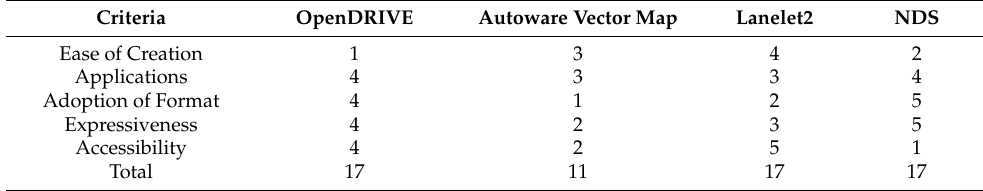
Table 1. Comparison of HD map formats based on various criteria which is adapted from [1]. Criteria